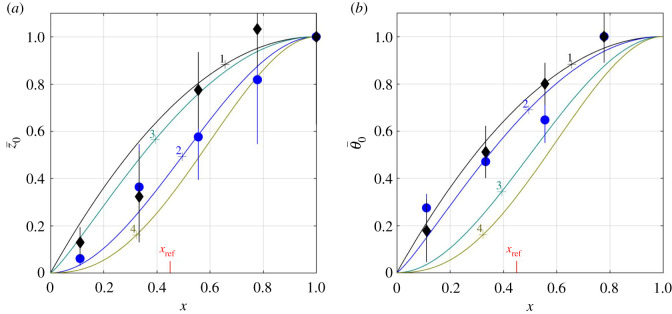
The four lines (numbered 1–4) depict four different combinations of z¯0 (a) and θ¯0 (b) from appendix J. Filled circles and diamonds (with the respective error bars) mark the amplitudes observed with H. platurus swimming at 0.3 and 0.6 body lengths per second, respectively [1].